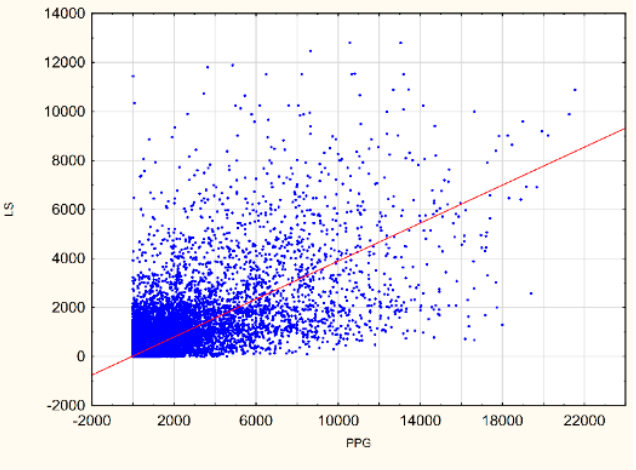
Figure 3. Scatterplot of PPG and LS.